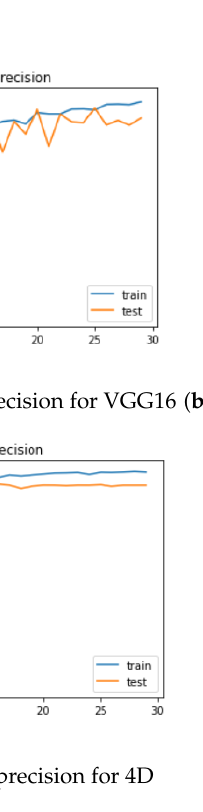
Figure 10. Training and testing precision curves for different models.